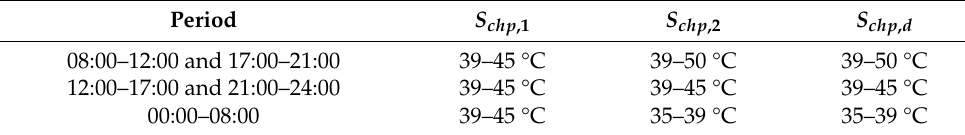
Table 4. The operation temperature range of three control strategies each period.